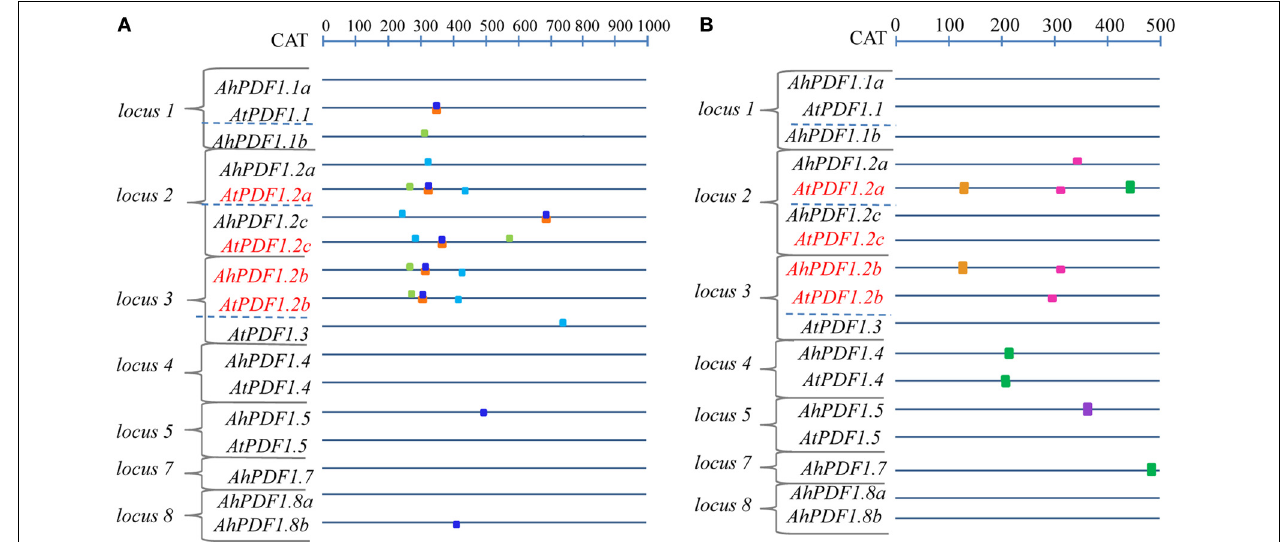
FIGURE 3 | Schematic architecture of upstream regions of PDF1 s in A. halleri and A. thaliana. The potential promoter sequence of the 17 A. halleri and A. thaliana PDF1 s are schematically represented, oriented upstream of the translation start codon from which the distance is indicated in bp on the above ruler. Red letters indicate PDF1 sets responding positively to MeJA. (A) Motifs over-represented in the 1kb-long upstream region of the PDF1 set